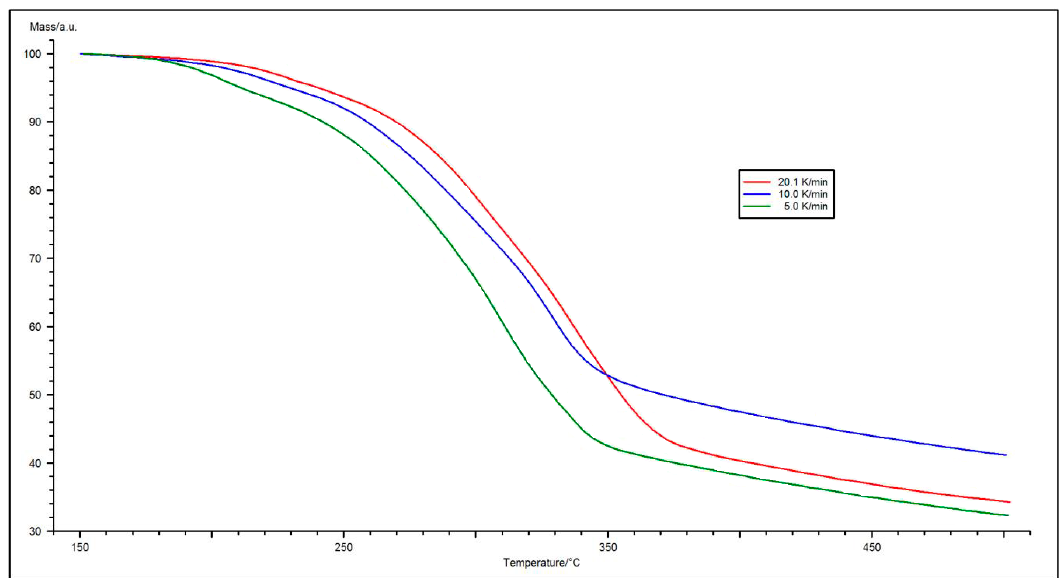
Figure 3. TG curves for three heating rates recorded for a maize straw sample.